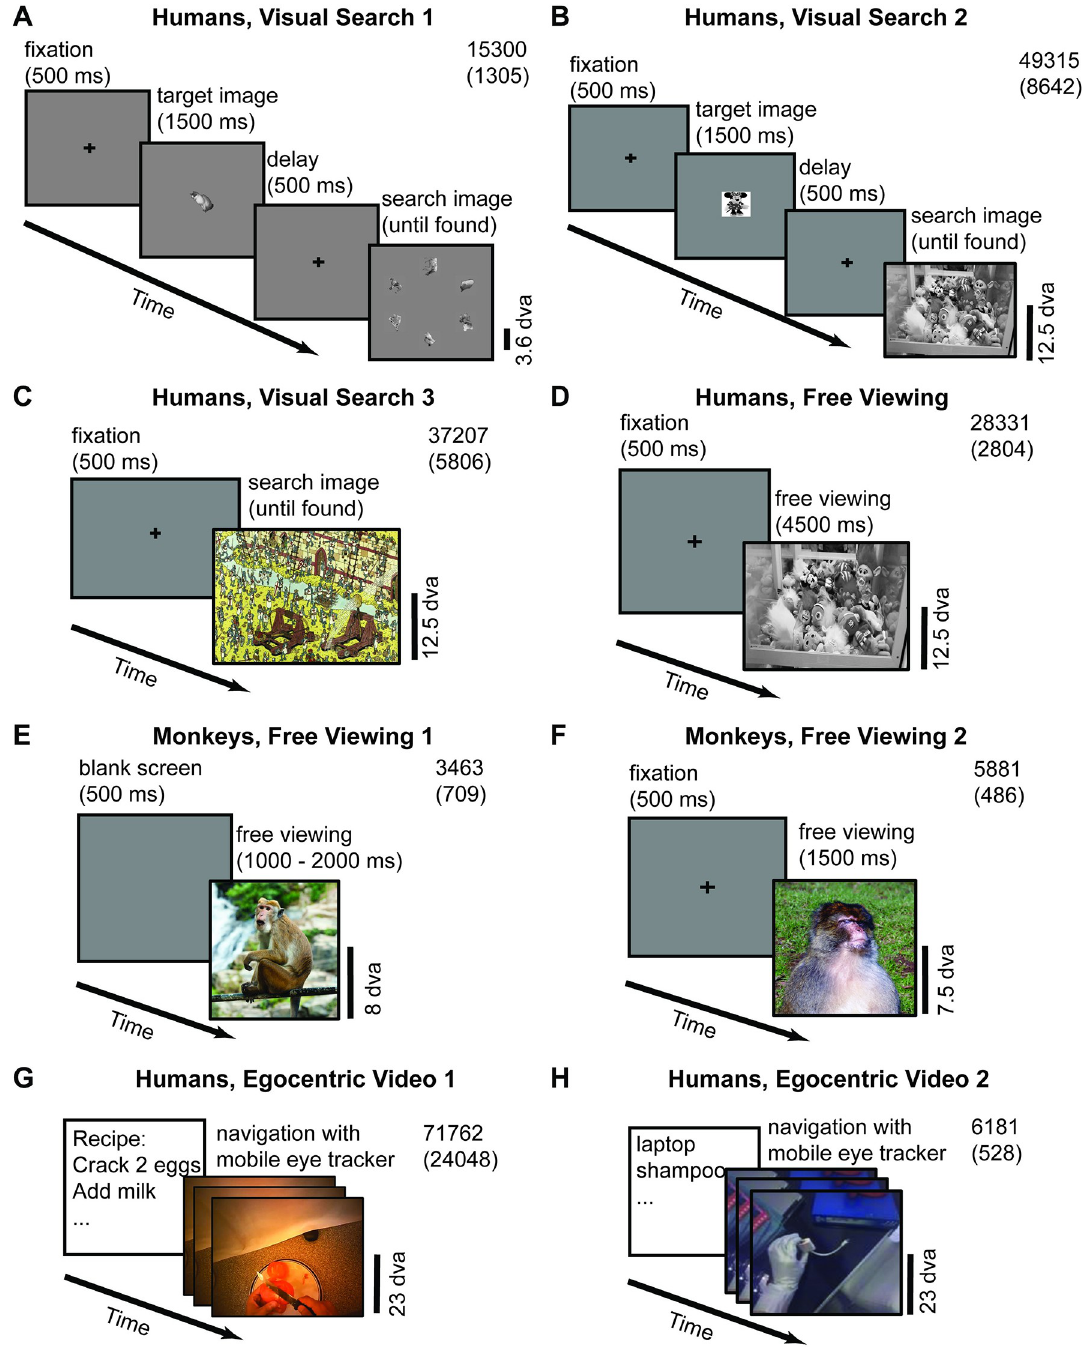
Fig 2. Schematic description of the eight experimental paradigms. ( A-C ) Visual search tasks with object arrays ( A ), natural images ( B ), and “Waldo” images ( C ) (see [8] for details). ( D-F ) Free viewing experiments with static natural images in humans ( D ) and monkeys ( E, F ). ( G ) Egocentric video dataset where subjects had to follow various recipes to make breakfast (see [48] for details). ( H ) Egocentric video dataset where subjects had to search for 22 items (see reference [49] for details). The numbers in the top right corner of each subplot denote the total number of fixations (top) and the total number of return fixations (bottom). Photo sources: (A, B, C, D) were modified from a public dataset [8]. (G) was modified from a public dataset [48]. (H) was modified from a public dataset [49]. (EF) Reproduced with permission from BPRC and